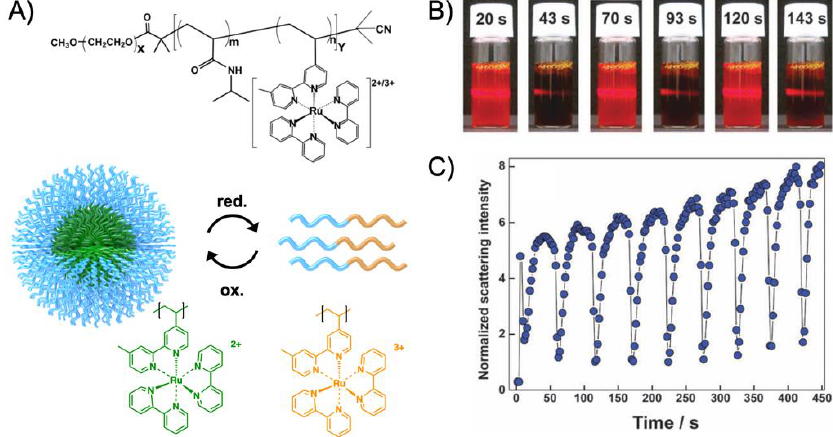
Figure 16. Self-oscillating micelles. ( A ) PEO- b -P(NIPAAm- r -Ru(bpy) 3 ) BCP and redox-responsive assembly / disassembly depending on the oxidative state of Ru(bpy) 3 . ( B ) Time-dependent scattering of the BCP solution synchronized to a BZ reaction. ( C ) Recorded scattering intensity over time showing oscillating formation / dissipation of BCP micelles. Adapted with permission of [136]. Copyright 2013 Royal Society of Chemistry.